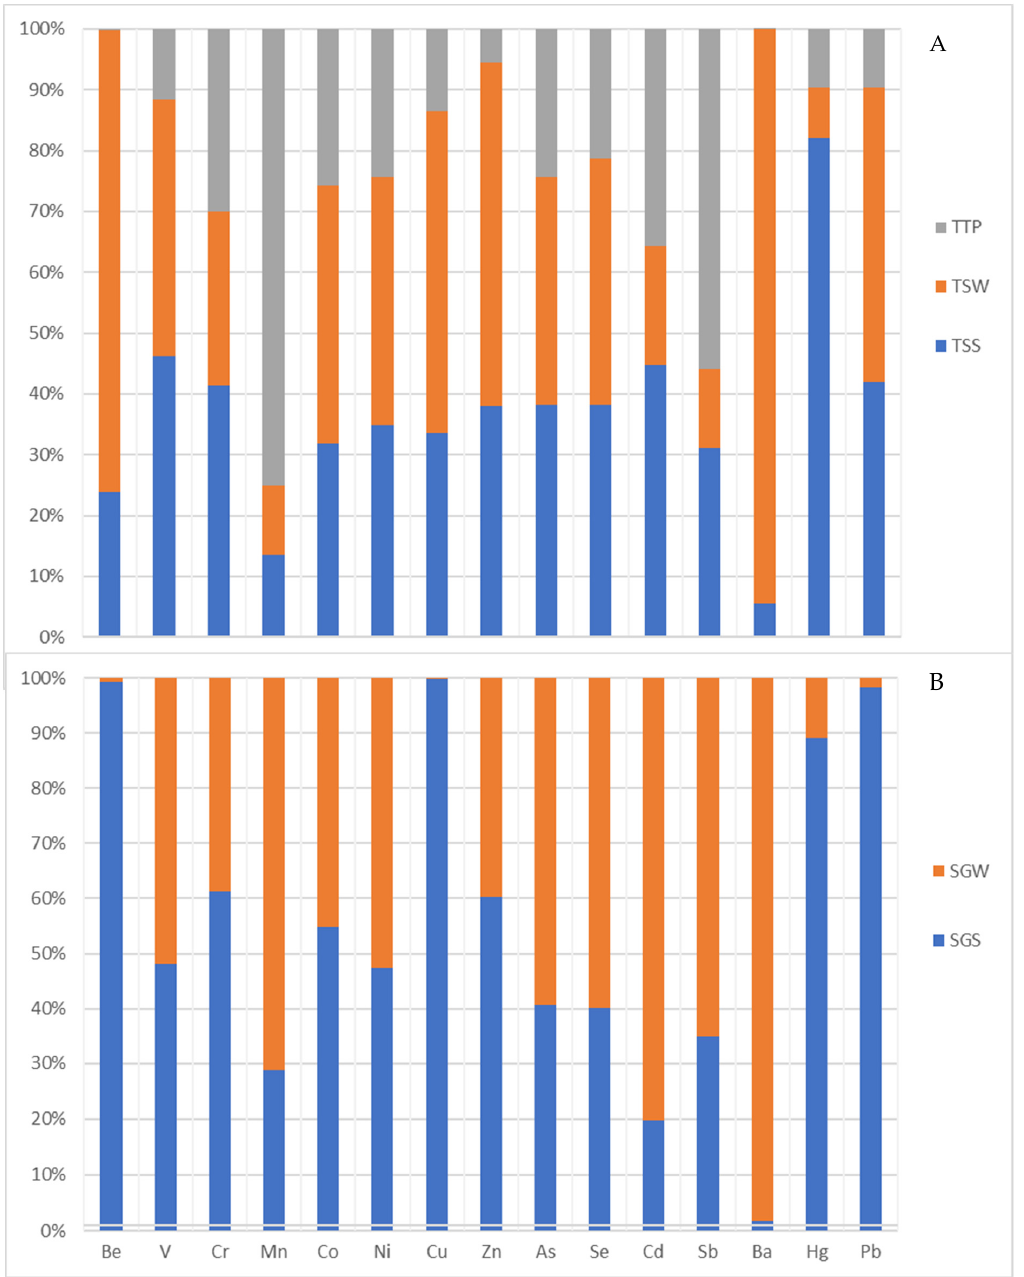
Figure 2. Variations of trace metals concentrations in (A) Tshipise geothermal spring and tepid borehole, and (B) Sagole geothermal spring.